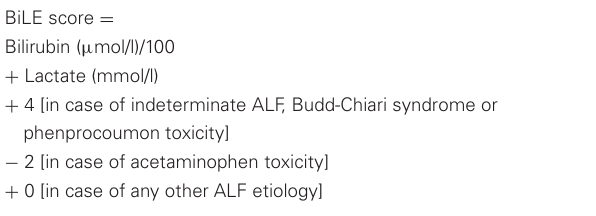
Table 3 | Bilirubin Lactate Etiology (BiLE)